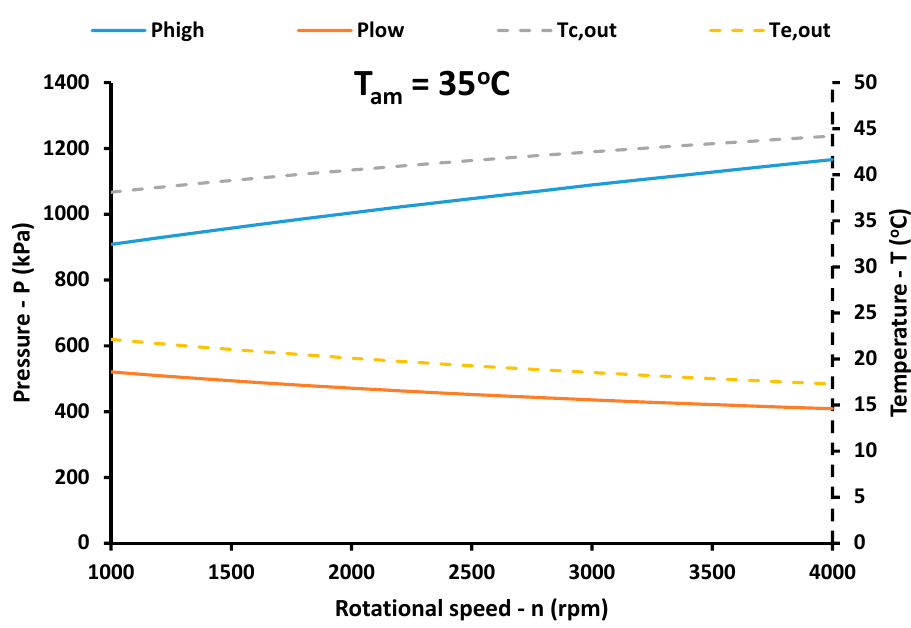
Figure 5. Pressure levels and outlet temperatures of the streams for different rotational speeds and ambient temperatures ( T ind = 25 °C).